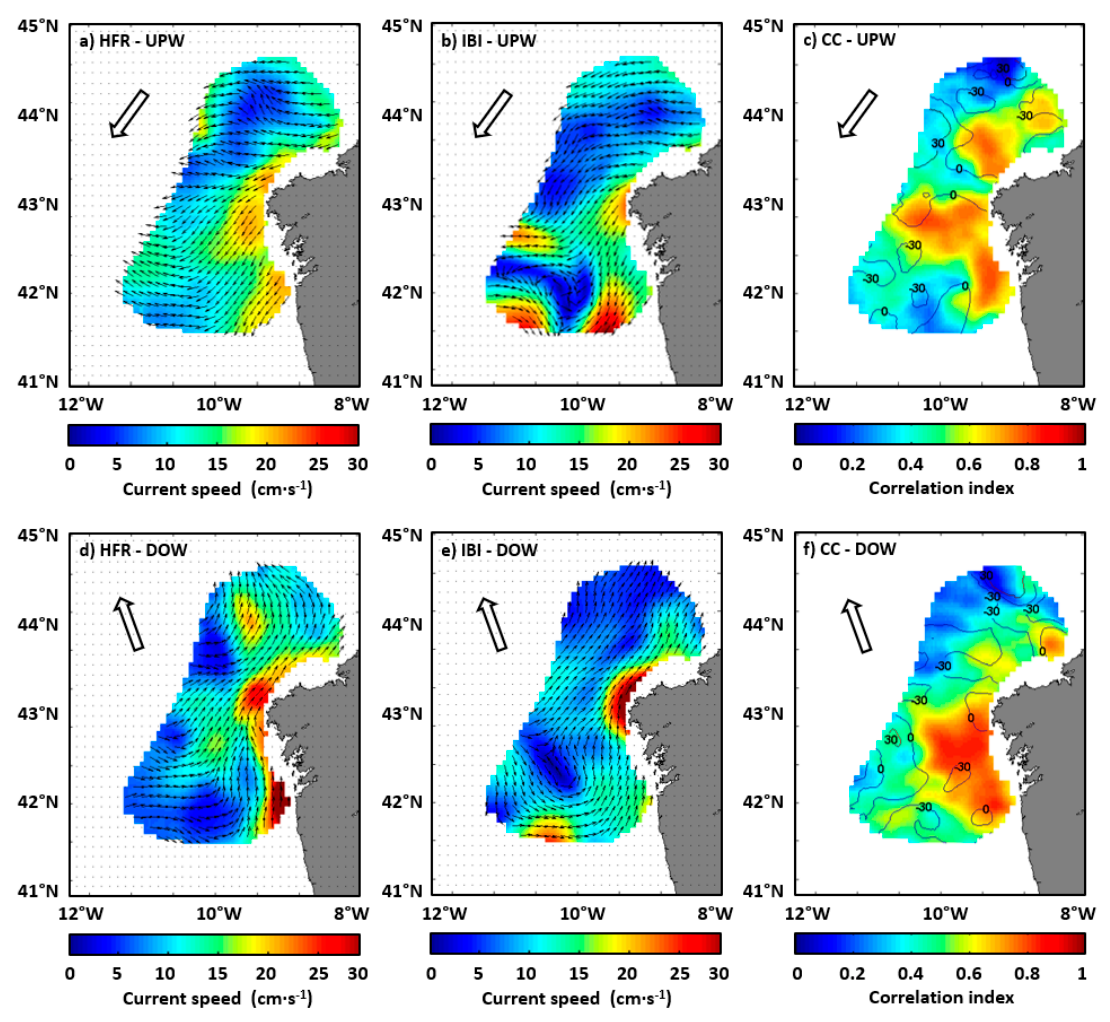
Figure 4. Ten-day averaged surface circulation patterns during upwelling (UPW, a – c ) and downwelling (DOW, d – f ) wind-driven events as observed with the high-frequency radar (HFR, a , d ) and modelled by IBI ocean forecast system ( b , e ). The associated complex correlation (CC) index between IBI and HFR is presented ( c , f ). The isolines show the veering. Bold arrows indicate the predominant propagation direction of the wind registered at B1 buoy (shown in Figure 1b) during the 10-day periods. By contrast, a rather uniform poleward surface circulation is evidenced in response to prevailing southerly winds during the DOW episode (Figure 4d,e). On the southern inner shelf, the interplay between the existing topographic barriers and the cross-shore transport led to a marked directional change of the coastal flow to the left, intensified in form of a narrow jet, the well-documented IPC, which circulated along the NW Iberian shelf edge [8,57]. Since river plumes are mainly